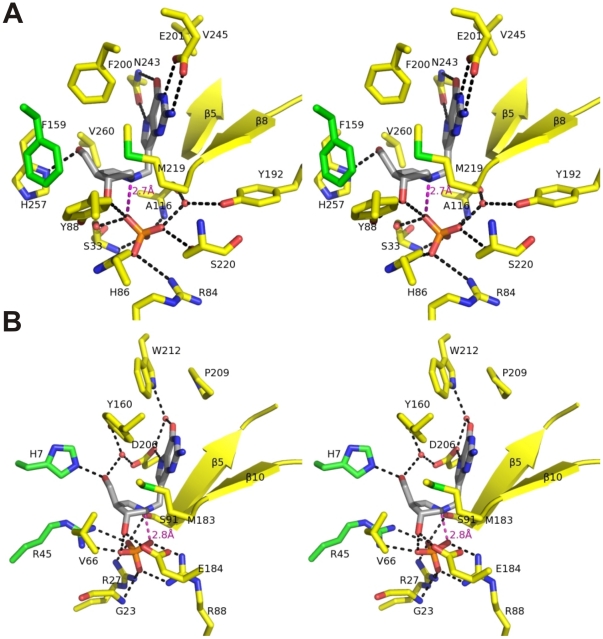
Stereo view crystal structure of BCX4945 and phosphate bound to hPNP and PfPNP.Crystal structures of hPNP-BCX4945-PO4 (A) and PfPNP-BCX4945-PO4 (B) were determined to 2.3 and 2.0 Å resolution, respectively. BCX4945 (grey) active site residues (yellow), residues from adjacent subunits (green) and phosphate (orange) are indicated. Hydrogen bonds are indicated as black dashed lines. The ion-pair interaction between the ribocation mimic and phosphate is indicated as a magenta dashed line with the distances indicated.